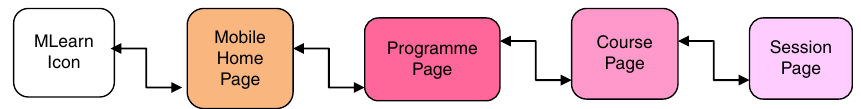
Figure 3. Navigational